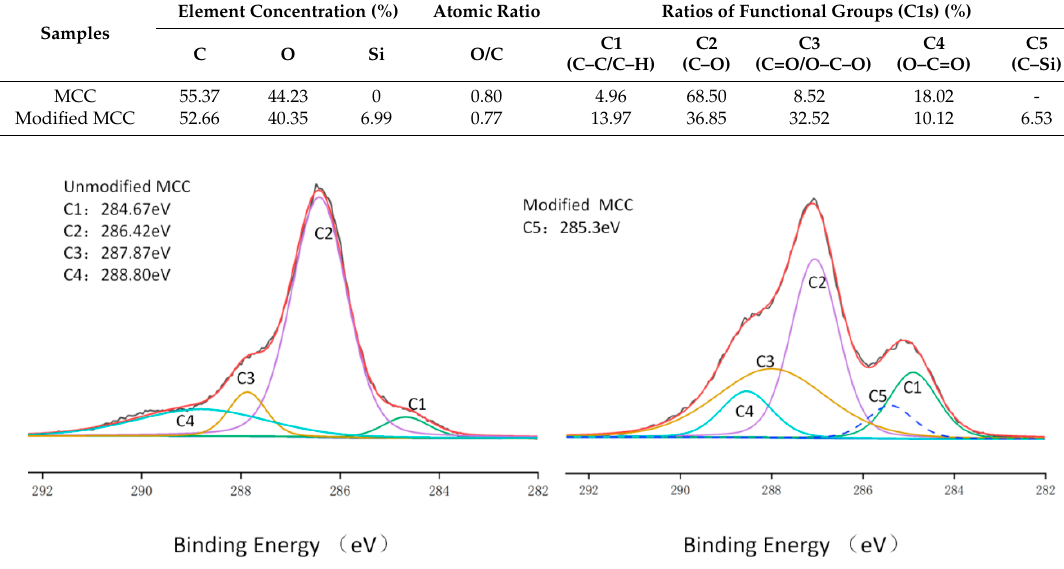
Figure 8. XPS high-resolution C1s spectra of MCC before and after surface modified.